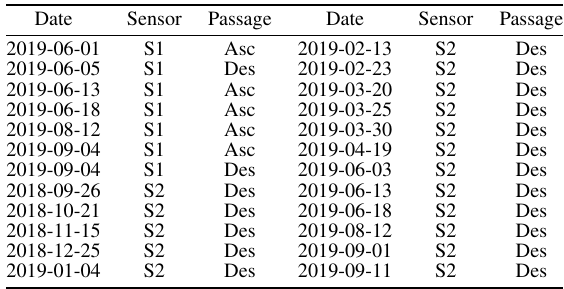
Table 2. SAR and optical images used in different scenarios.